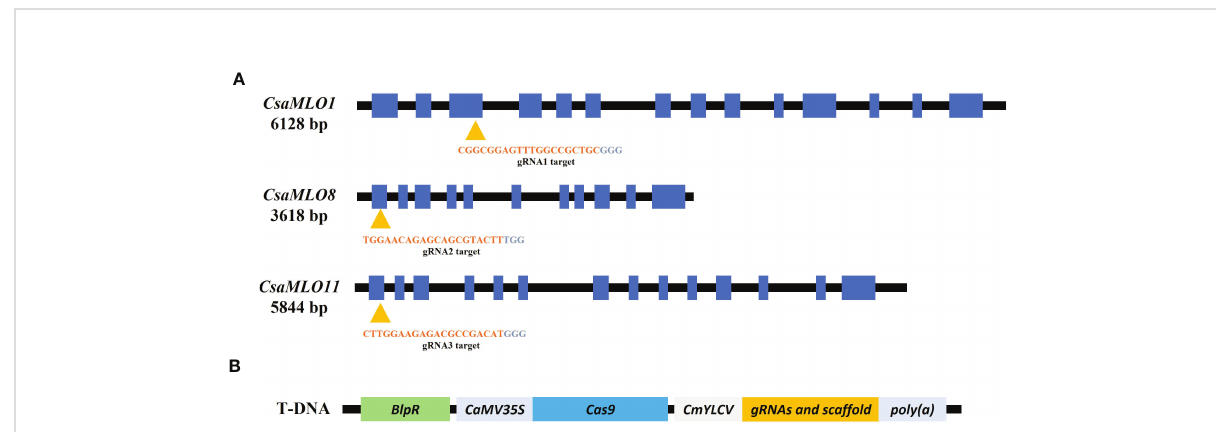
FIGURE 1 Speci fi c gRNAs chosen from the coding site of Clade V CsaMLO (CDS) in cucumber and pDIRECT_23C plasmid. (A) gRNA1 for CsaMLO1 , gRNA2 for CsaMLO8 , and gRNA3 for CsaMLO11 were selected by using CRISPR-GE. (B) Selected gRNAs were ampli fi ed with PCR and cloned into pDIRECT_23C ’ s. Cestrum yellow leaf curling virus promoter (CmYLCV) was used for gRNAs expression and bialaphos phosphinothricin resistance (BlpR) was used to transgenic plant selection. Also, pDIRECT_23C contains Cauli fl ower Mosaic Virus 35S promoter (CaMV35) for